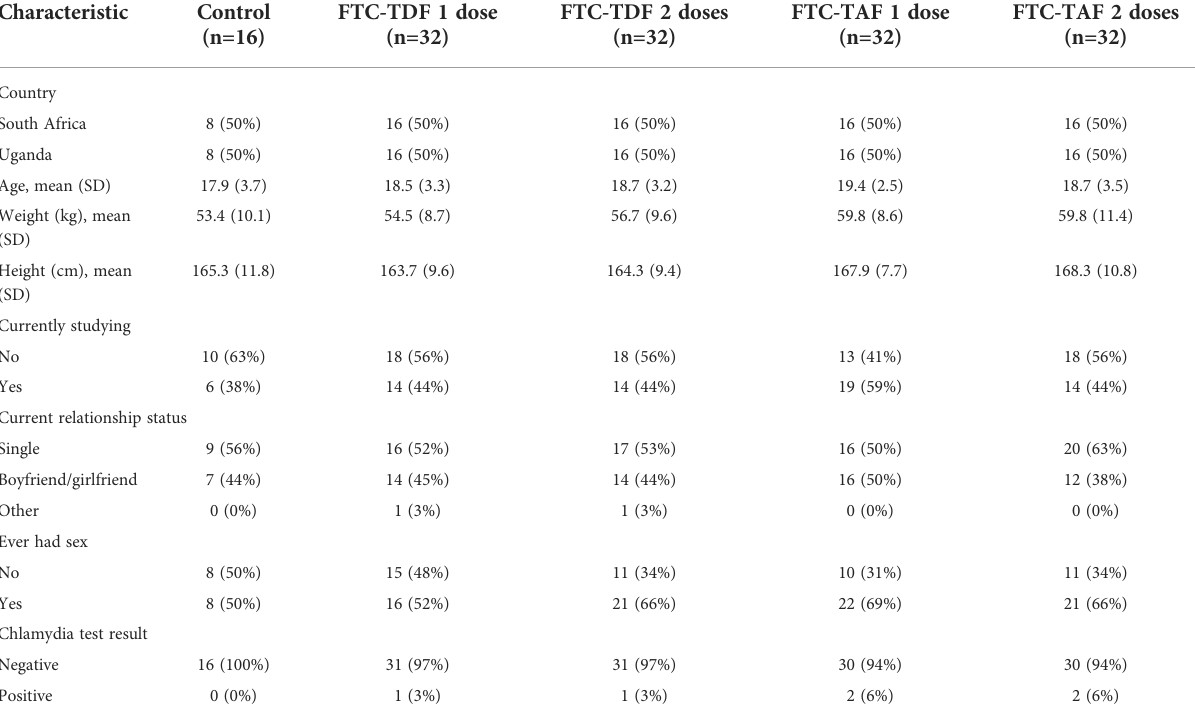
TABLE 1 Characteristics of study participants by number of PrEP doses.